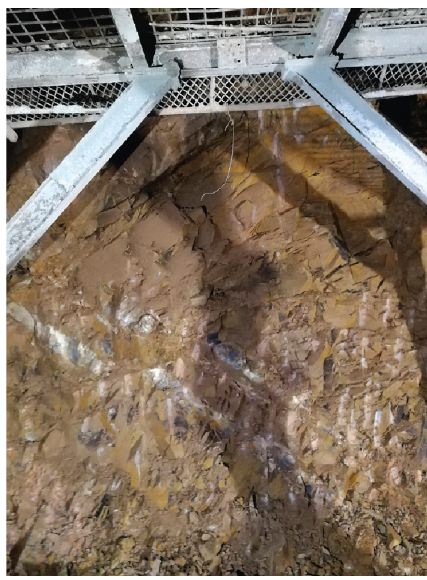
Figure 2: Geological picture of palm face in blasting excavation of ramp I of Gaojiu road.